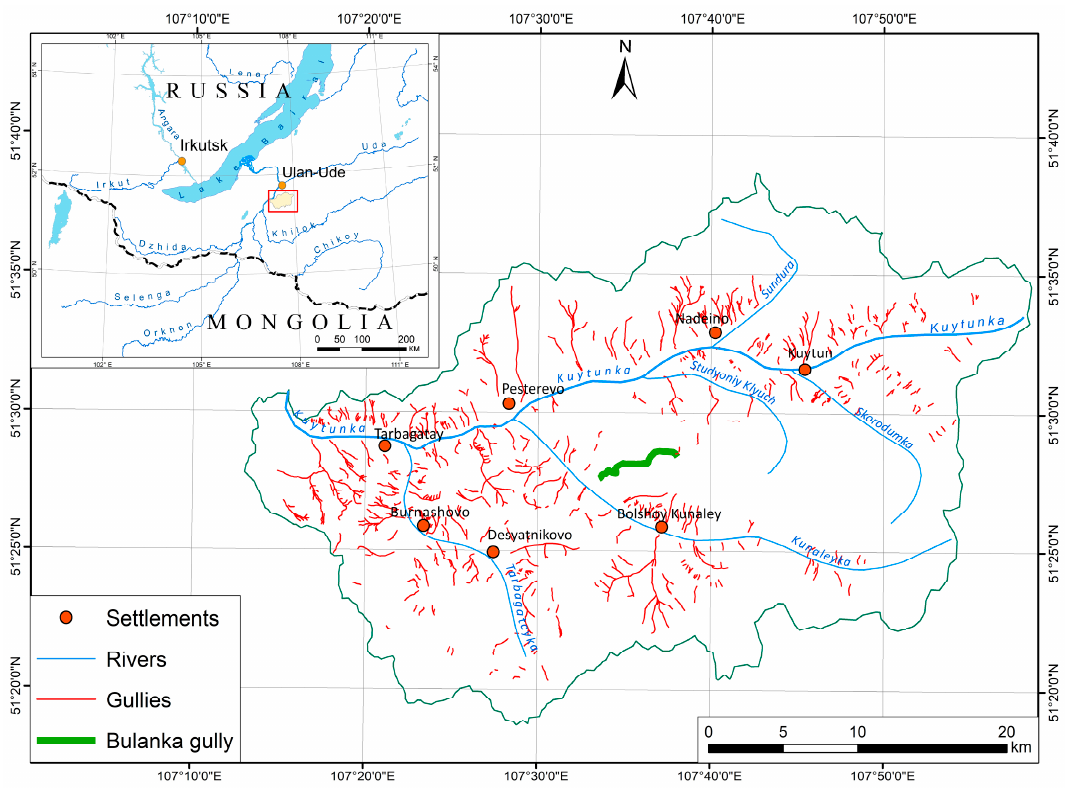
Figure 1. Gully network of the Kuitunka river basin.